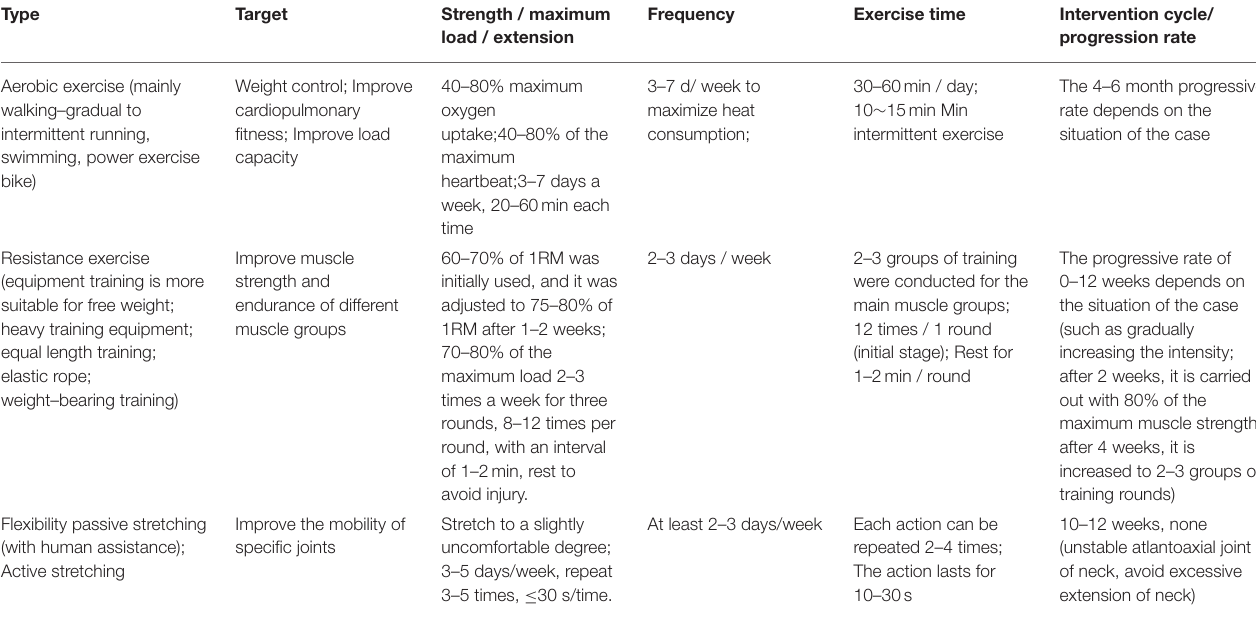
TABLE 1 | The American Sports Medical Association (ACSM) exercise prescription recommendations for people with intellectual disabilities.